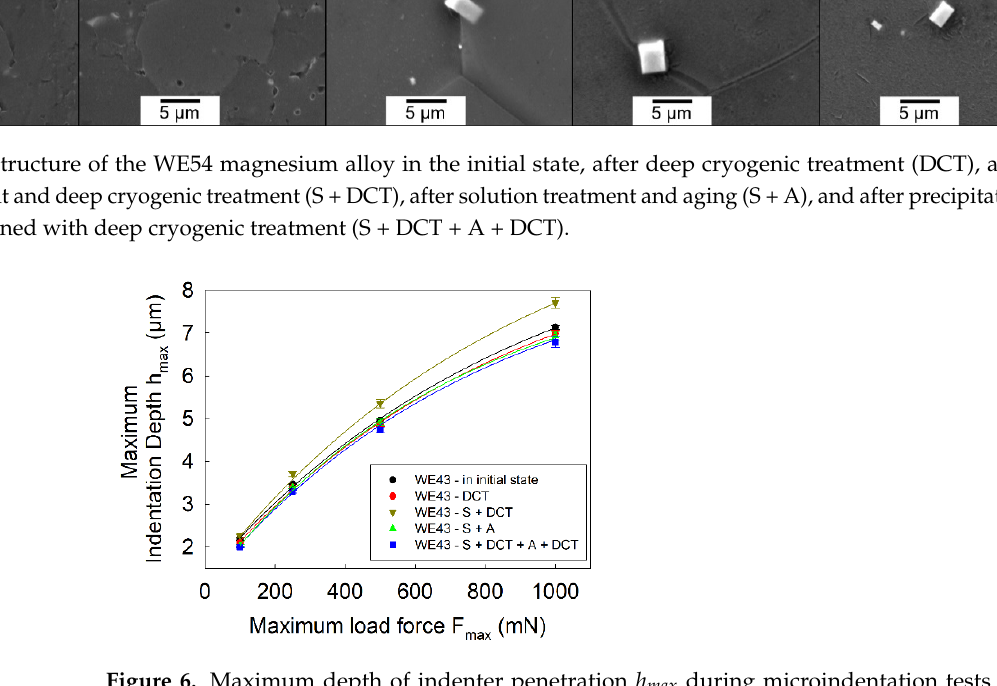
µ hmax = 0.02–0.13